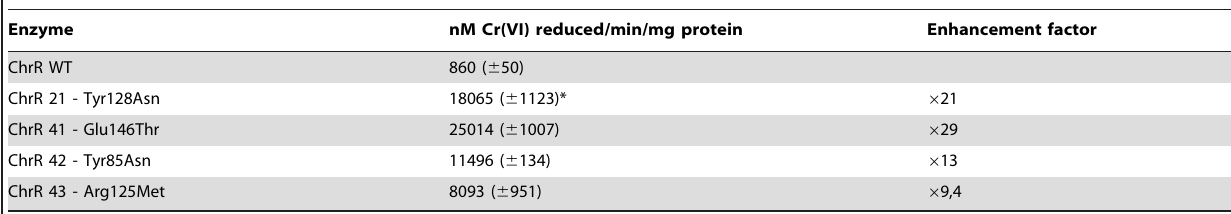
Table 2. Chromate reductase activity of ChrR mutant enzymes.